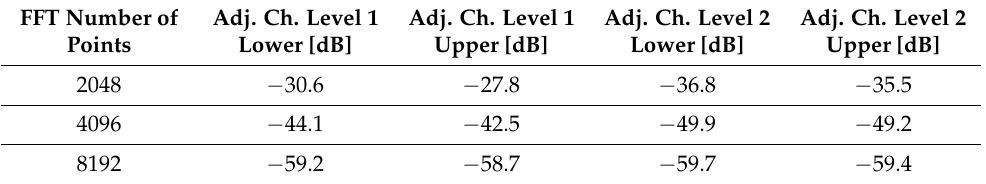
Table 4. Influence of FFT resolution on the attenuation of the adjacent channels, for the ADALM Pluto SDR platform (TETRA channel no.131, input signal level − 42